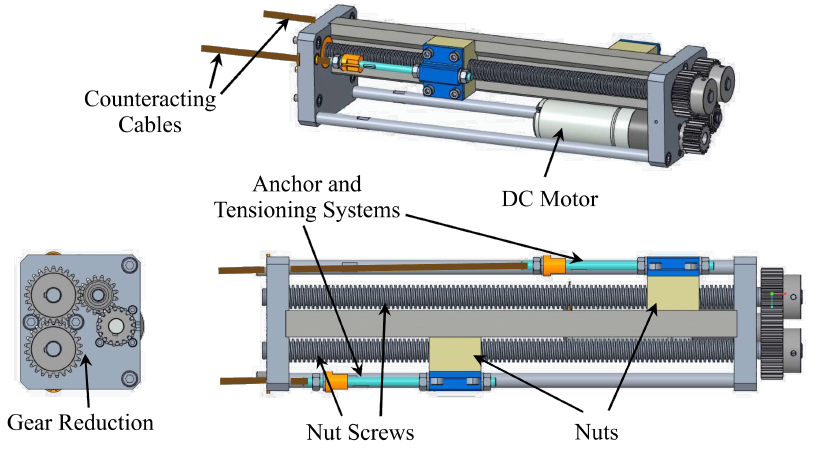
Figure 7. CAD drawing of the linear